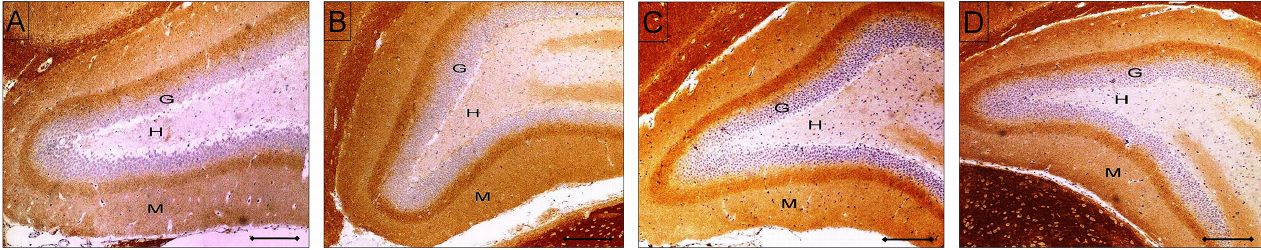
FIGURE 4 – GAP-43 immunoreactivity in the various layers of the dentate gyrus under low magnification in the control group (A), stressed group (B), tocotrienol-treated group (C) and the stressed group treated with tocotrienol (D). Note that GAP-43 immunoreactivity was the strongest in the inner molecular layer and the weakest in the granular cell layer. Measurement of GAP- 43 optical density was performed on the outer molecular layer of the dentate gyrus. G – granular cell layer; H – hilus of the dentate gyrus; M – molecular layer. Scale bar represents 150